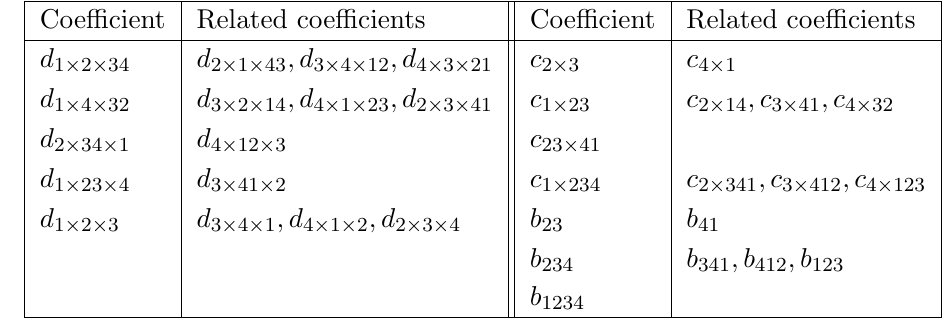
2 + 3 (cid:0) 4 (cid:0) g g g g